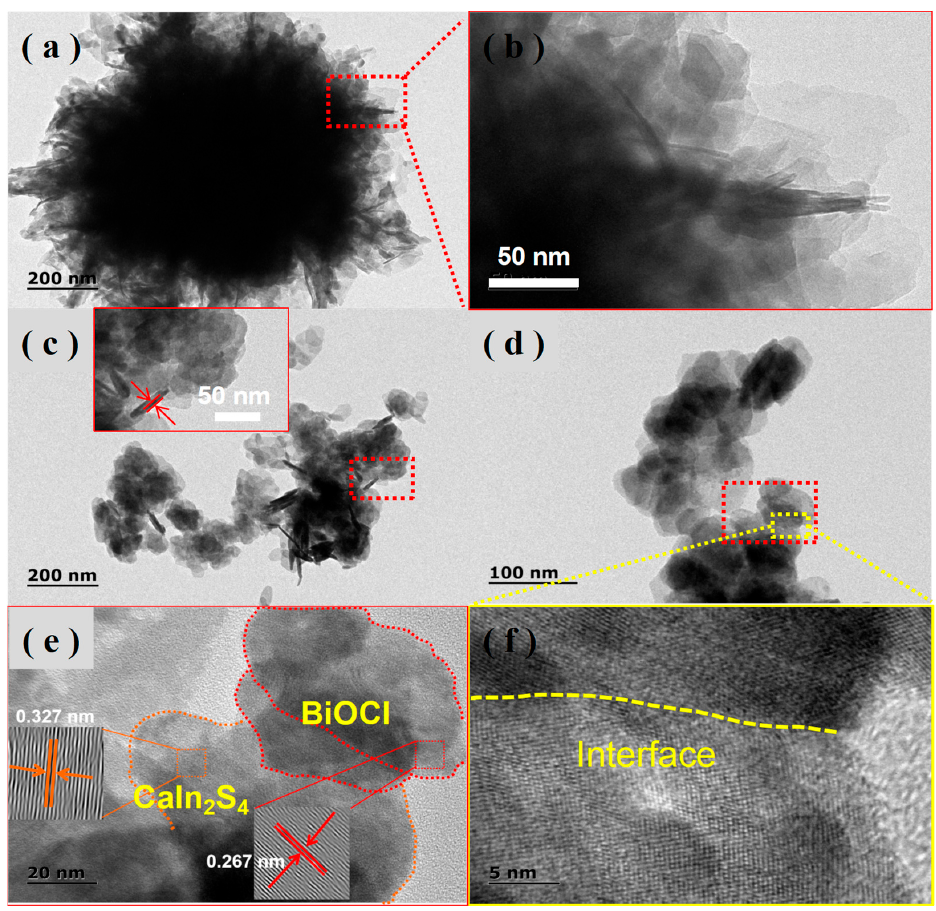
Figure 5. TEM image of ( a , b ) CaIn 2 S 4 , ( c ) BOC-SOVs, ( d – f ) 1% CIS/BOC-SOVs.